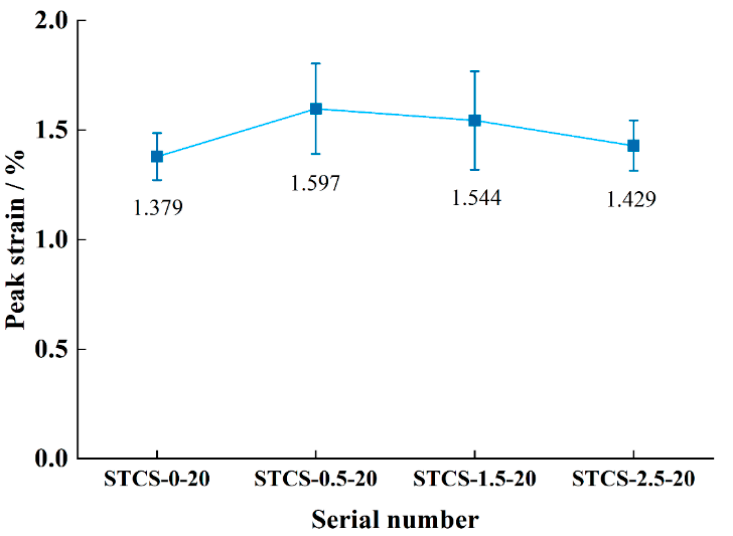
Figure 11. Peak strength of STCS.